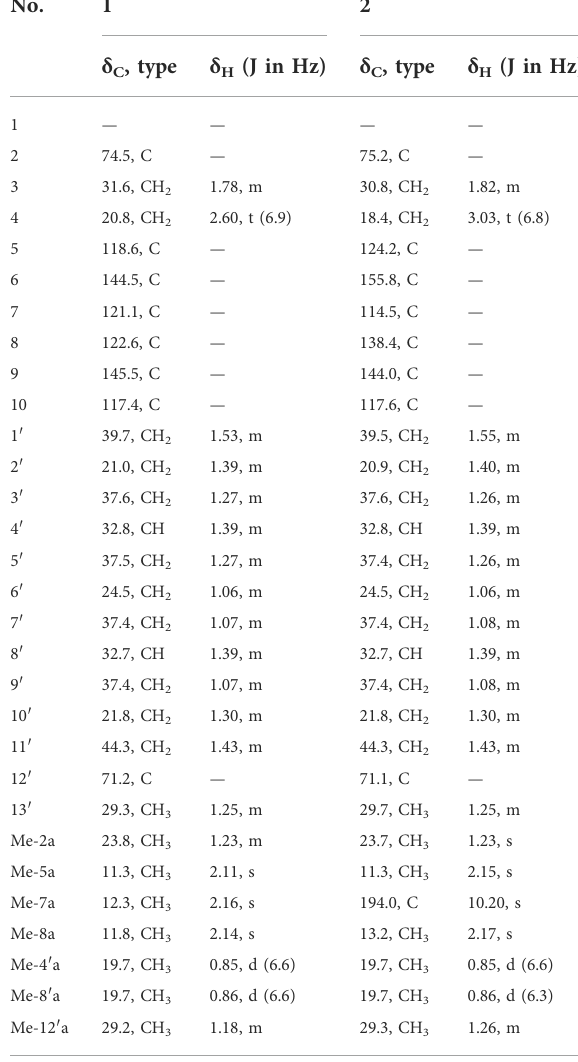
TABLE 1 1 H and 13 C NMR (600 MHz) data for 1 and 2 in CDCl 3